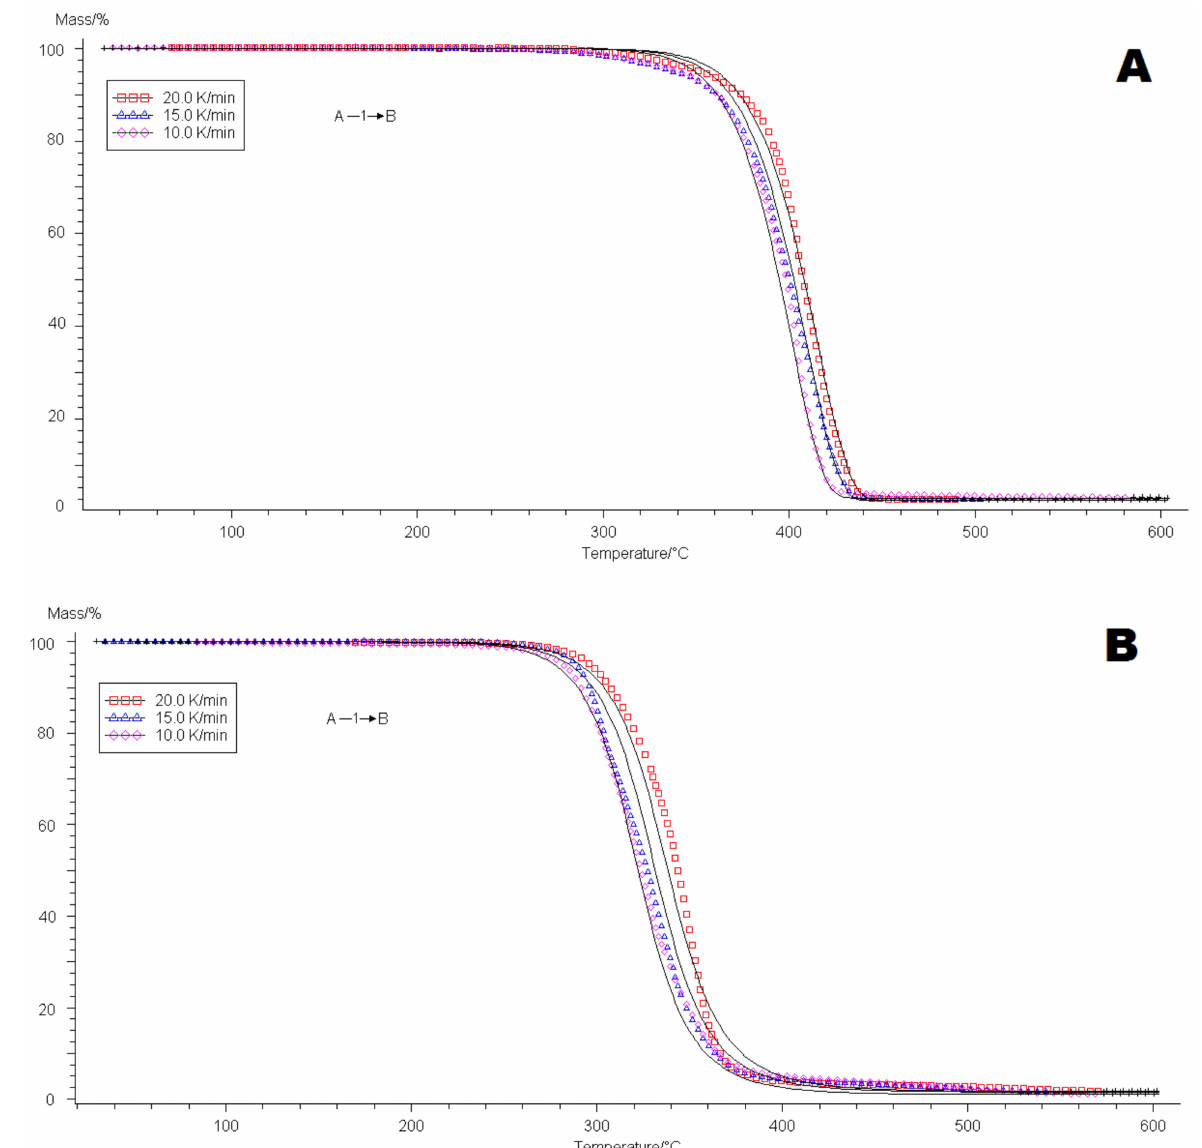
Figure A9. Experimental points for POM-O sample, investigated with 10, 15, and 20 ◦ C/min heating rates, represented by simulated solid lines: ( A ) investigations carried out in oxygen atmosphere; ( B ) investigations carried out in inert atmosphere. For the simulation, the apparent activation energy was used as the function of